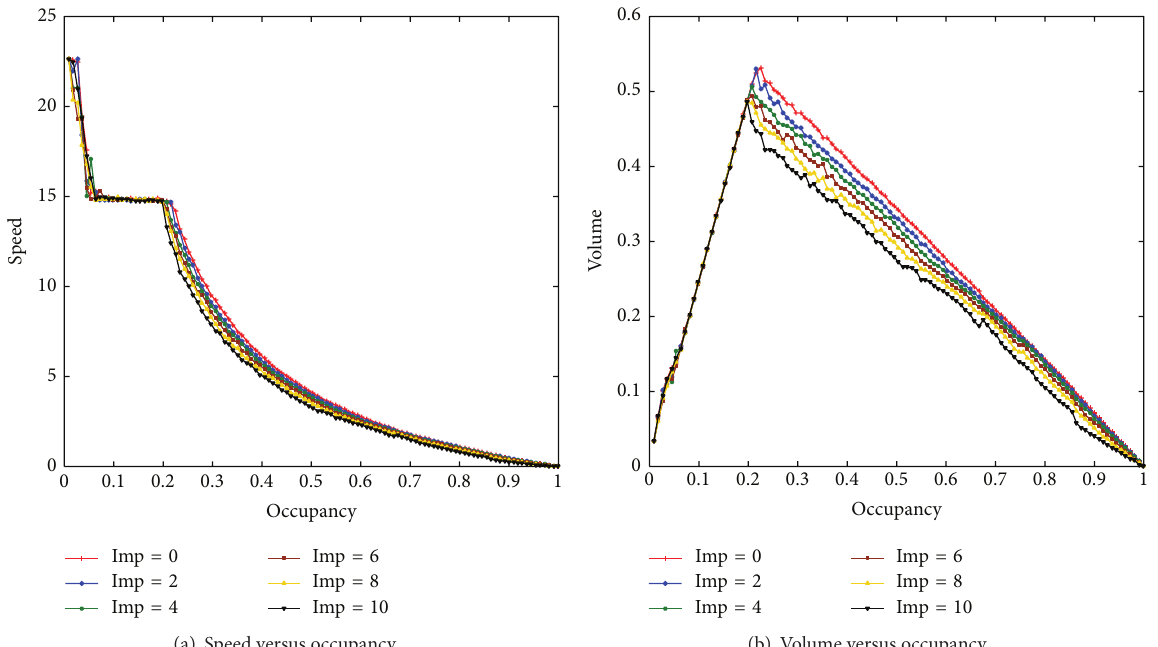
Figure 4: The fundamental diagram under different imp when 𝑟 = 0.2